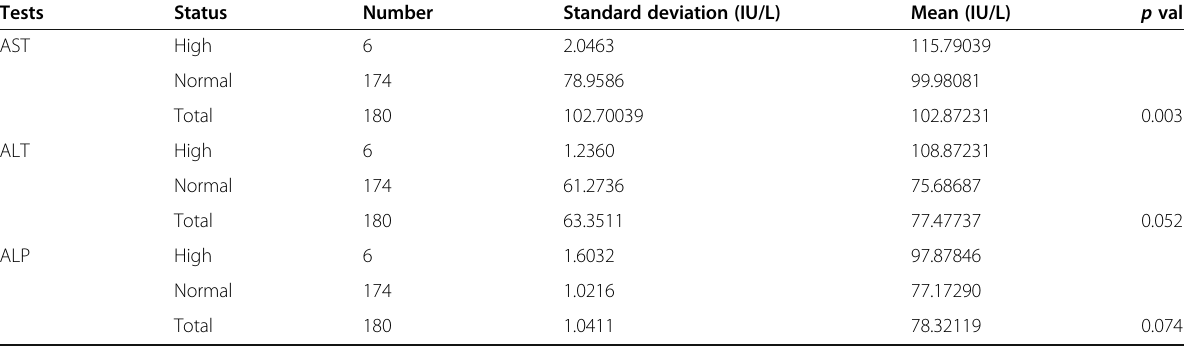
Table 4 Liver enzyme profiles among hepatitis D antibody-seropositive patients